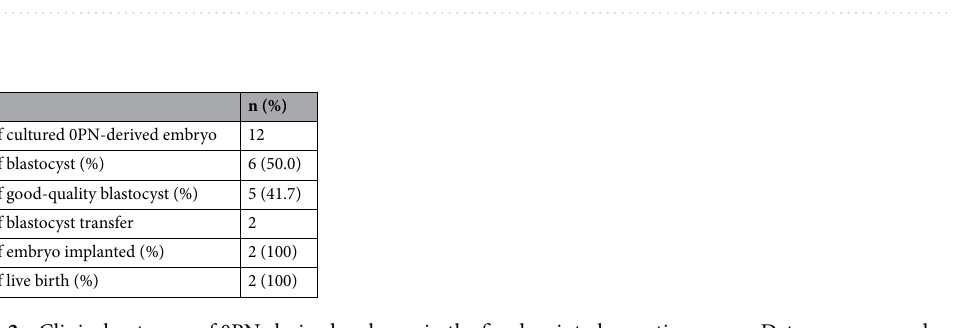
Table 3. Clinical outcome of 0PN-derived embryos in the fixed-point observation group. Data are expressed as numbers (percentages).